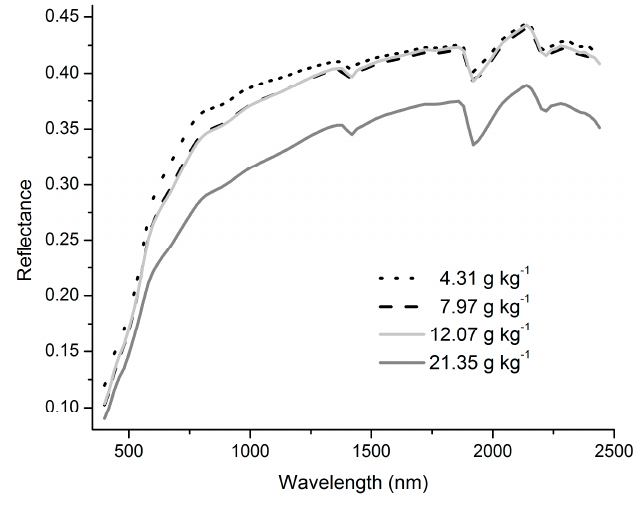
Figure 3. Average reflectance of four groups and their corresponding soil organic carbon contents (g·kg − 1 ).